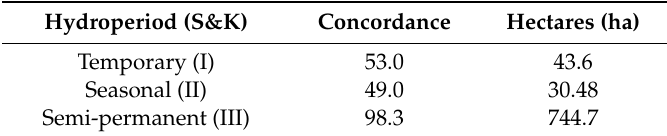
Figure 4. Surface water hydroperiod results, 2015 ( a ) and 2016 ( b ), over an URSA subset AOI. Yellow hydroperiod indicates temporary (1–2 months), green for seasonal (3–4 months), and blue for semi-permanent/permanent (5–6 months). 2016 Titan Lidar DEM illustrates topography and canopy cover. Table 5. Hydroperiod class concordance and hectares (ha) area comparison between 2015 and 2016 for URSA.